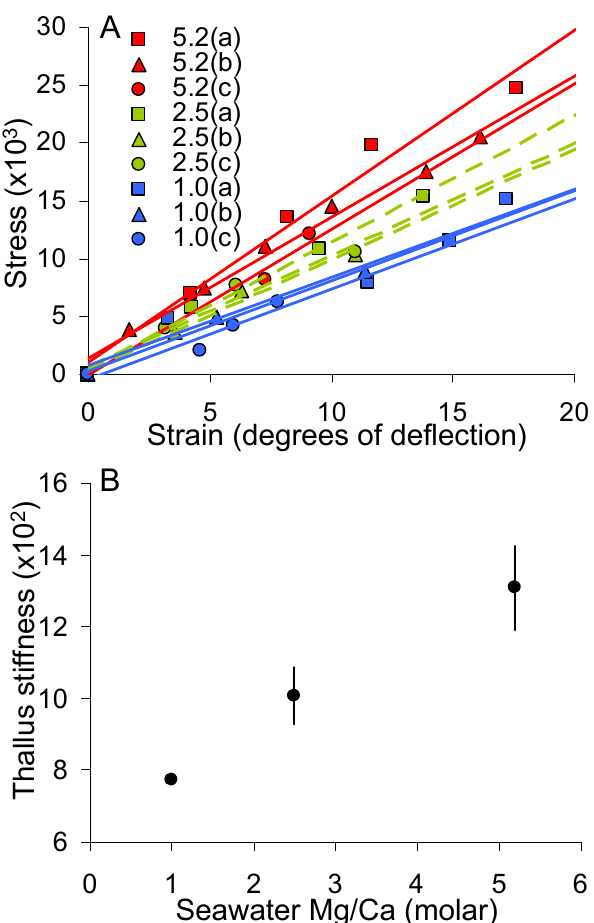
Fig. 10. (A) Stress-strain data generated for the thalli of nine Peni- cillus capitatus algae reared in the three seawater treatments (from Ries, 2005a). Stress-strain curves were generated by fitting linear regressions to the data using the least squares method. The solid red, dashed green, and solid blue curves correspond to P. capitatus algae reared in experimental seawaters formulated with Mg/Ca of 5.2, 2.5 and 1.0, respectively. Average stiffnesses were calculated from the slopes of these stress-strain curves and plotted against sea- water Mg/Ca in panel (B) . Thallus stiffness decreased significantly ( p < 0 . 001) with reductions in seawater Mg/Ca, such that algae were most stiff when reared in seawater that supports precipitation of their inherent aragonite skeletal mineral (Mg/Ca=5.2) and least stiff in seawater that supports the nucleation of calcite (Mg/Ca=1.0). Error bars represent standard